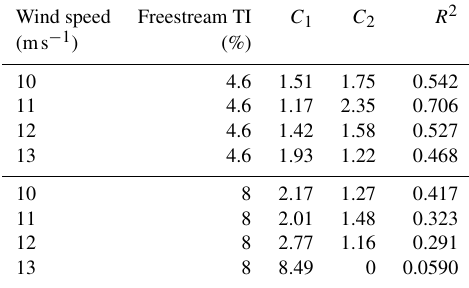
Table 3. Tuning constants for the turbulence data shown in Fig. 8. Wind